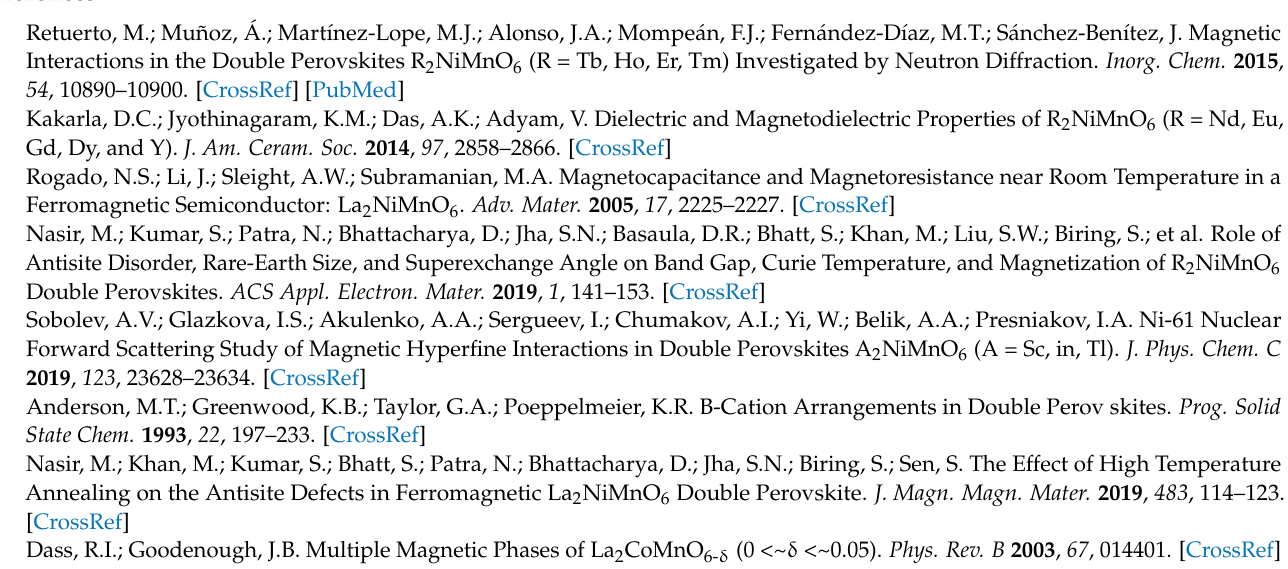
NRs; Figure S2: Temperature dependent dielectric permittivity ( ε r ) and its reciprocal (1000/ ε r ) of the LNMO ceramics prepared from (a,b) NPs and (c,d) NRs; Figure S3: Plots of ln function of ln ( T − T m ) for the LNMO ceramics prepared from NPs measured at (a) 4 kHz, (b) 10 kHz, (c) 80 kHz, and (d) 100 kHz; Figure S4: Plots of ln Comparison between the magnetic data and Curie-Weiss fitting parameters of the